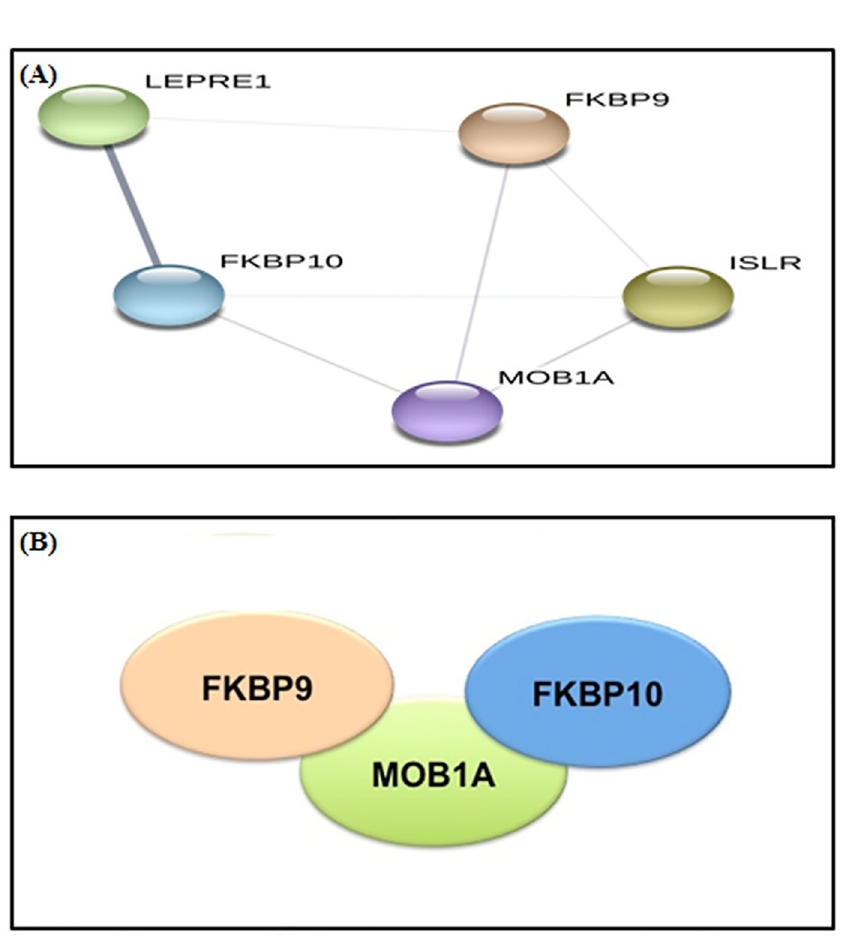
Fig 5. (A) Functional network of proteins in stage 2 breast cancer samples, (confidence level = 0.150). (B) Molecular pathway of proteins as predicted by STRING. Schematic representation of potential protein-protein interactions. This is predicted directly by DAVID, each ellipse represents a protein, and the representation suggests the interaction pathway. In this case, MOB1A interacts independently with FKBP9 and